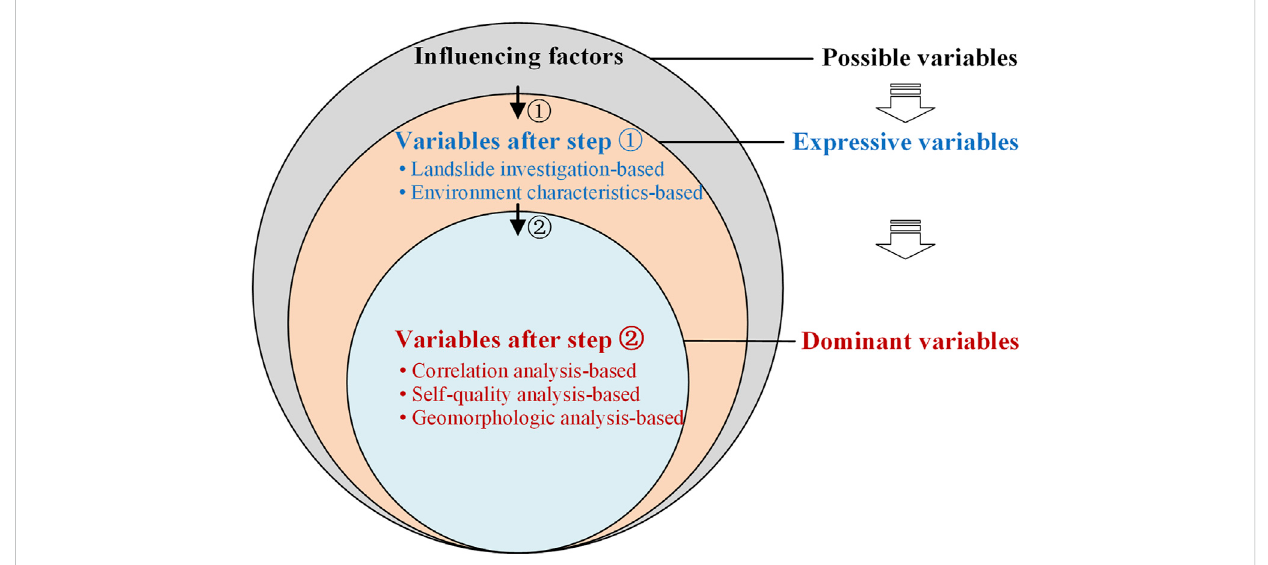
FIGURE 5 Proposed approach for identifying dominant environmental variables. In fl uencing factors are variables that may affect the spatial distribution of landslides. Step ① indicates the screening procedure of expressive variables based on fi eld investigations and the researchers ’ recognition of environmentalcharacteristics. Variables after step ① indicate thosethat are more expressive inenvironmental characteristics,and arescreened fromthe qualitative perspective. Step ② indicates the identi fi cation procedure of dominant variables based on the correlation analysis of landslides and